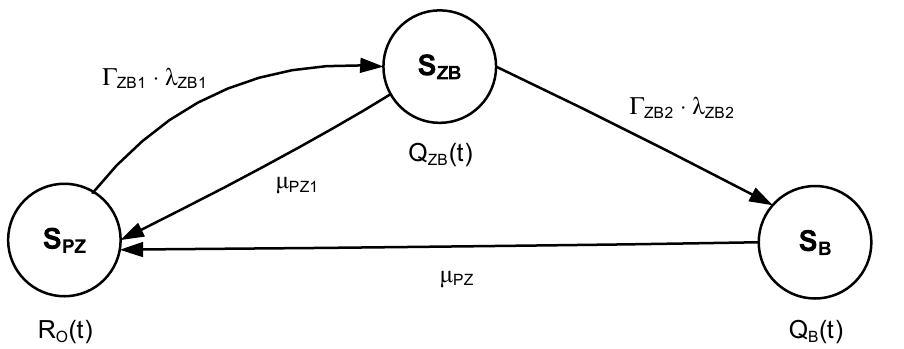
Figure 19. Functional relations within an electronic security system, taking into account the impact of unintentionally generated electromagnetic interference. Designations in Figure: R O (t) —probability function for an ESS to stay in state S PZ ; Q ZB (t) —probability function for an ESS to stay in state S ZB ; Q B (t) —probability function for an ESS to stay in state S B ; λ ZB1 —intensity of transitions from state S PZ to state S ZB ; μ PZ1 —intensity of transitions from state S ZB to state S PZ ; λ ZB2 —intensity of transitions from state Q ZB to state Q B ; μ PZ —intensity of transitions from state Q B to state S PZ ; Γ ZB1 and Γ ZB2 — electromagnetic interference impact coefficients.